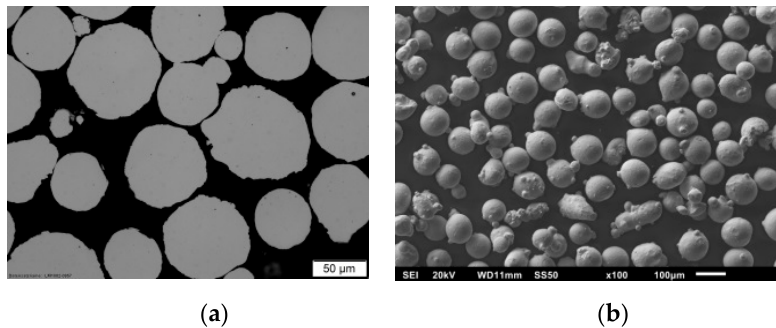
Figure 9. Metallographic images of the 316L-Si powder, ( a ) cutting image, ( b ) SEM image.